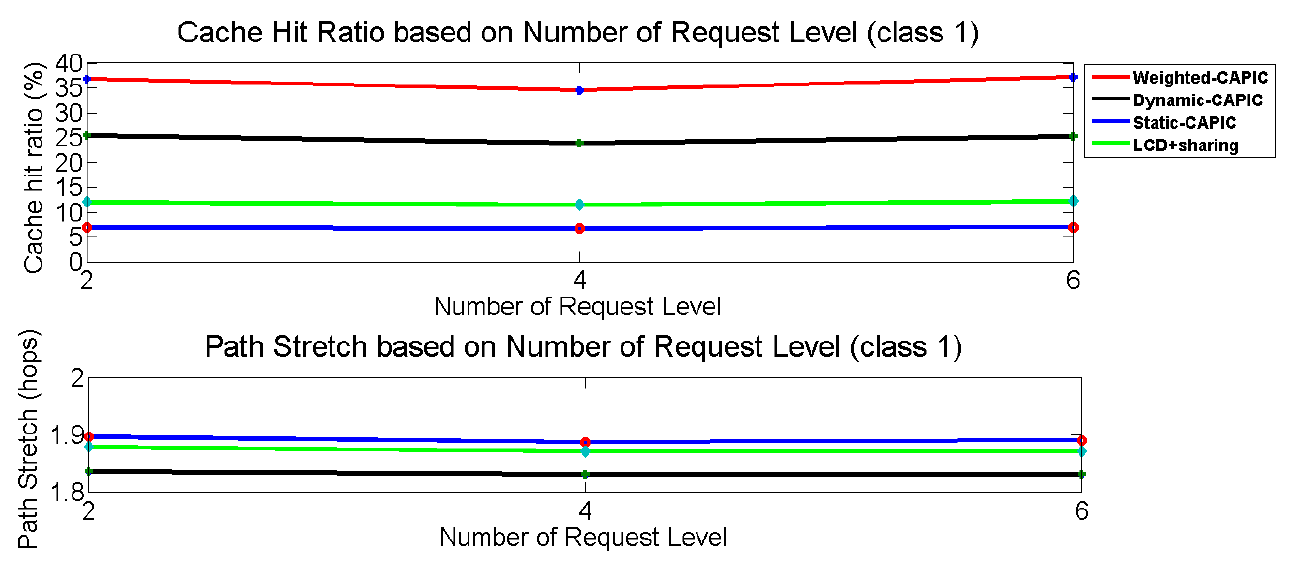
Figure 2. Cache hit ratio and path stretch of class 1 for various level of